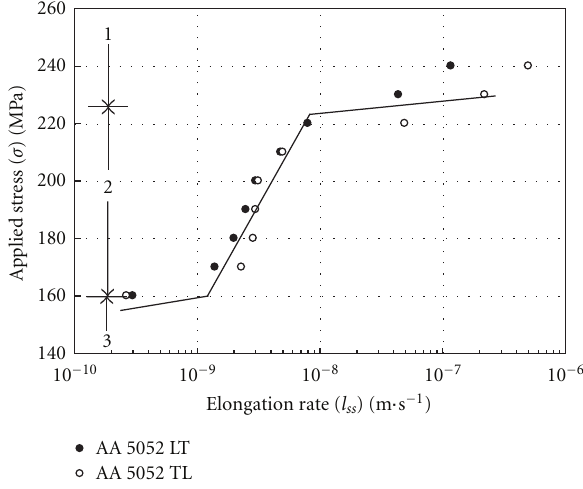
Figure 4: The logarithm of steady-state elongation rate ( l ss ) versus applied stress ( σ ) for A5052-H3 in a 0.5M sodium chloride solution.